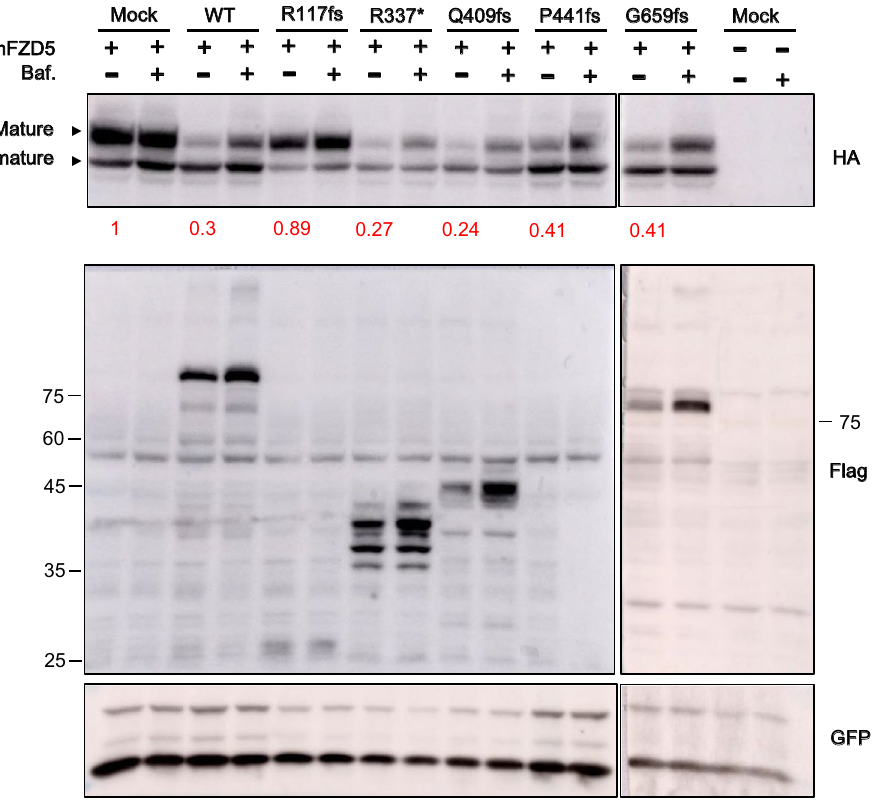
Figure 3. WT and mutant RNF43 regulate protein expression of the FZD receptor. WT RNF43 downregulated the protein expression of mFZD5. R117s overexpression had no effect on mFZD5 protein expression. Treatment of cells with bafilomycin A1 (Baf) rescued FZD5 protein expression from WT RNF43, and other RNF43 mutants mediated downregulation. The protein levels of mature FZD5 were quantified using Image J and the values are represented below the